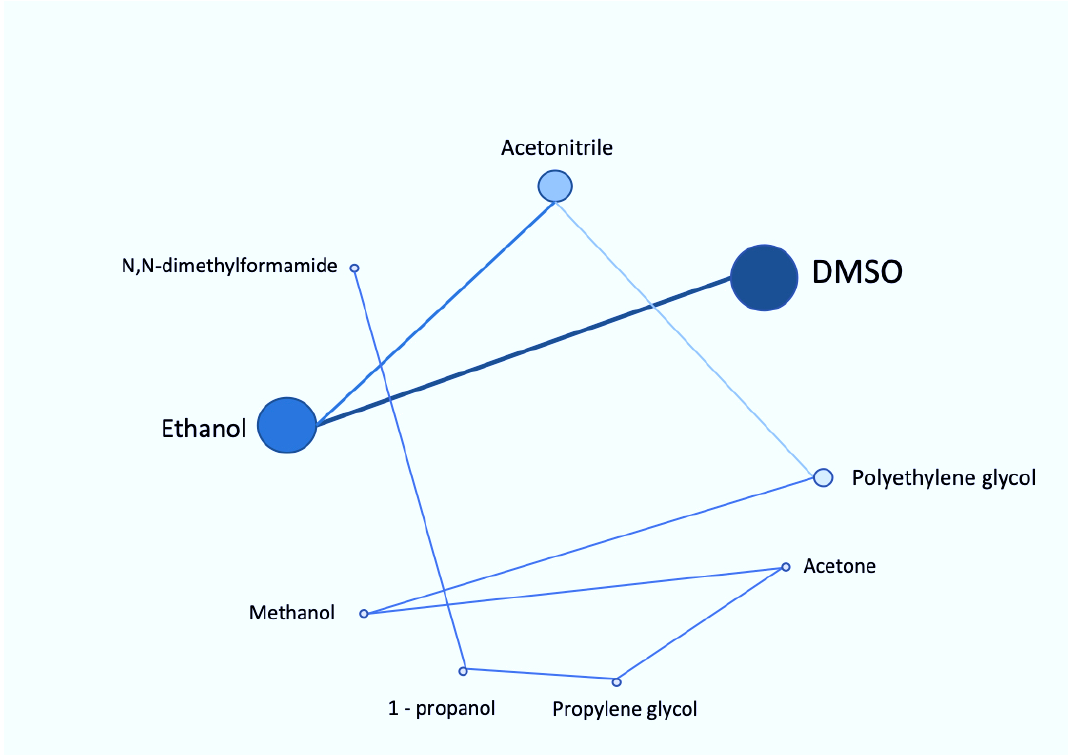
Figure 3. Roadmap of various reported organic solvents based on their inhibitory effect on CYP450 system. The size of each circle represents the potency of various organic solvents and the lines depict the order of inhibition: from DMSO being the most potent to N,N-dimethylformamide being the least.